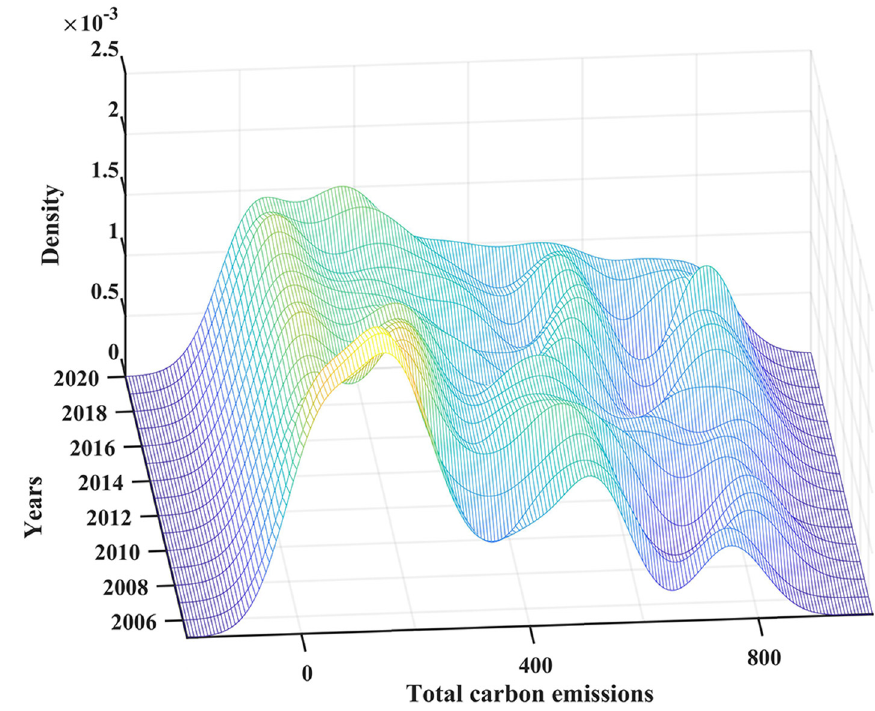
Figure 5. Kernel density curve of marine fisheries’ CO 2 . Figure 5. kernel density curve of marine fisheries’ CO 2 .